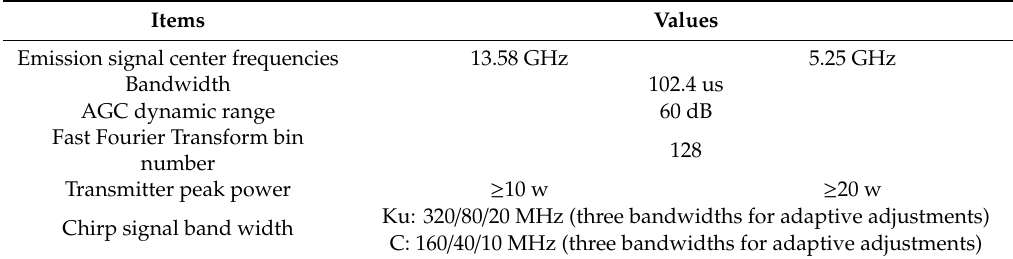
Table 1. Altimeter parameters (Source: http: // www.nsoas.org.cn / ). Items Values Emission signal center